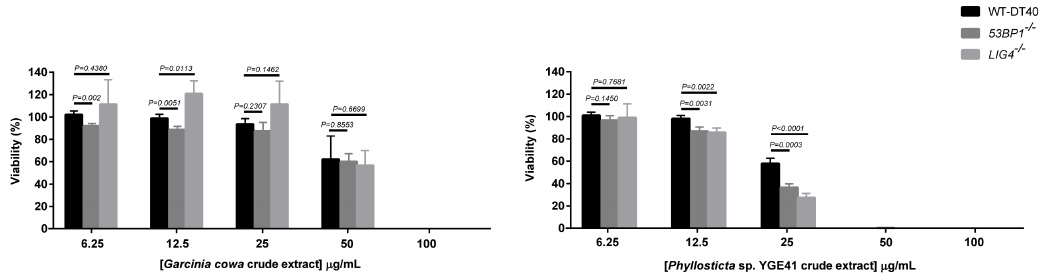
Figure 9. Garcinia cowa and Phyllosticta sp. YGE41 crude extracts di ff erentially a ff ected NHEJ-deficient cells. The cells were treated continuously with ethyl acetate crude metabolites from Garcinia cowa Roxb. Ex Choisy and Phyllosticta sp. YGE41 to determine cell viability. The experiment was repeated with biologically independent replicates. Data are shown as the mean ± standard deviation. Student’s t -test was performed at 6.25, 12.5, 25, and 50 µ g / mL of Garcinia cowa and Phyllosticta sp. YGE41. Definitions: DMSO, dimethyl sulfoxide; 53BP1 − / − , 53BP1 knockout; RAD54L − / − , RAD54L